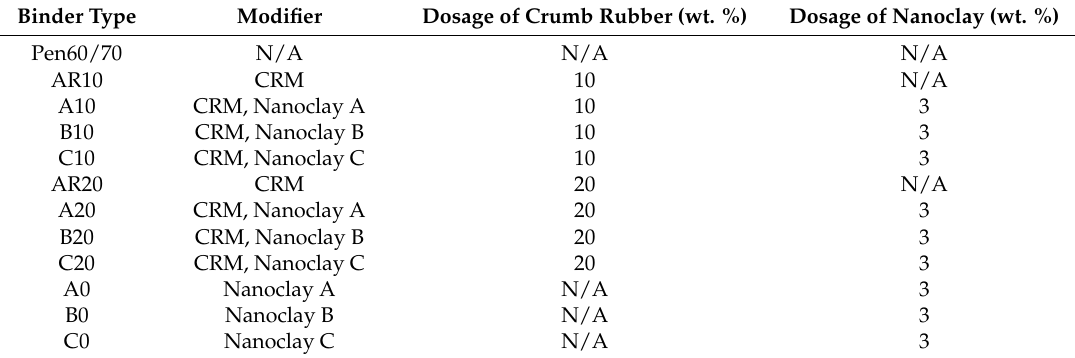
Table 2. Composition of different modified asphalt rubber